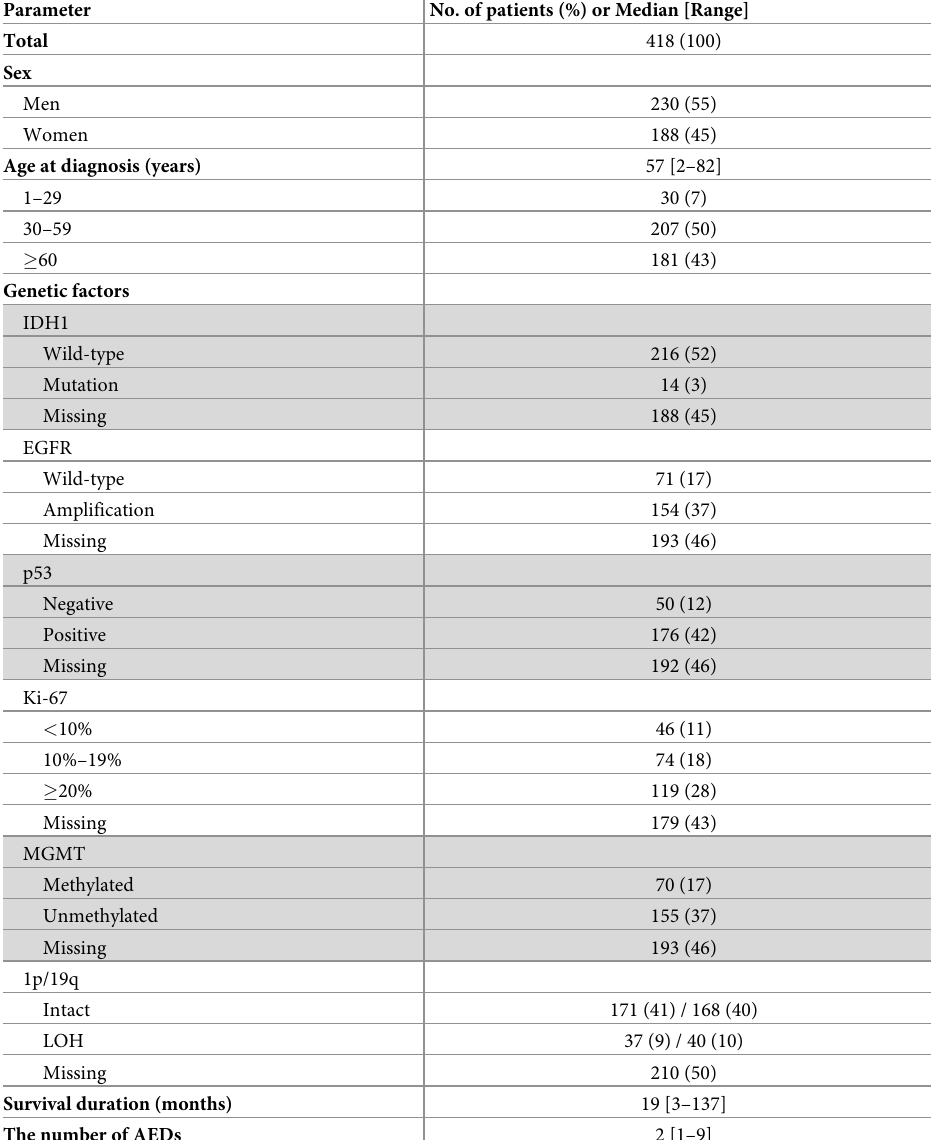
Table 1. The baseline clinical characteristics of